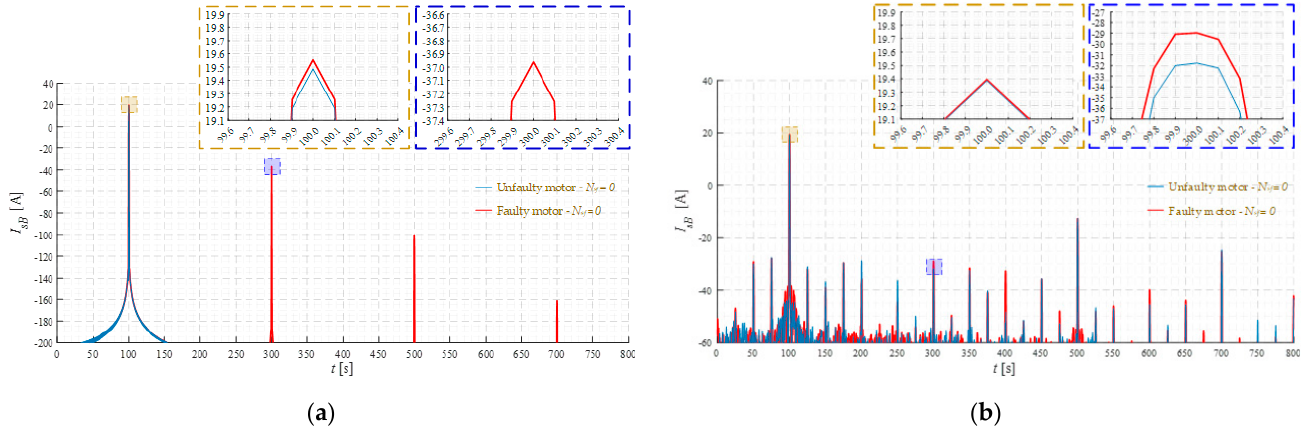
Figure 3. The spectral analysis of the PMSM stator current in phase B : ( a ) simulation results; ( b ) experimental results; T L =